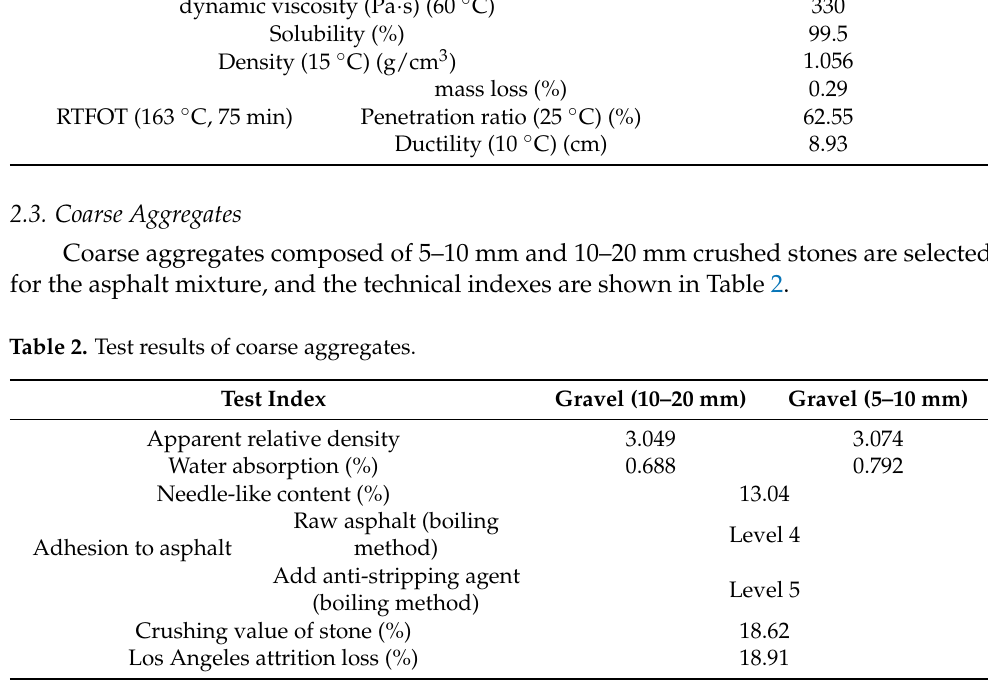
Table 1. Test results of main technical indexes of asphalt.